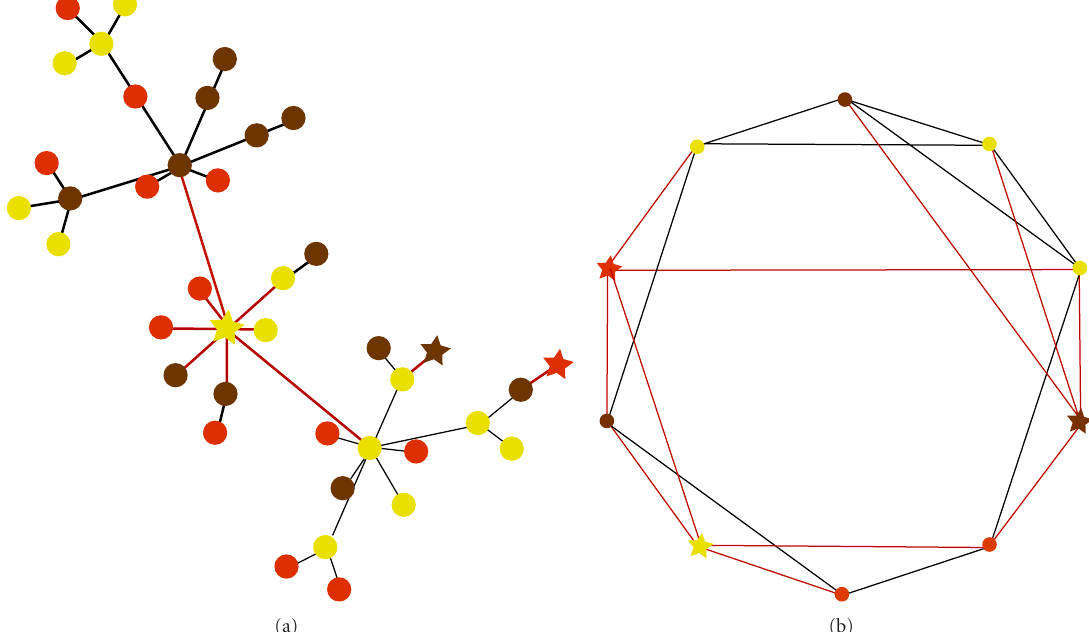
Figure 1: Diverse (a) BA network and (b) WS network seeded with viruses at time step t = 0. Both networks have L = 3 di ff erent colored node types. Circular nodes are susceptible and star-shaped nodes are infected. There is S = 1 seed for each node type. Only the L · S = 3 seeds are infected since the viruses have not started to spread. The viruses infecting the seeds control all adjacent edges (shown in red). The BA network has four isolated nodes in addition to the three infected seeds. Only the seeds are isolated in the WS